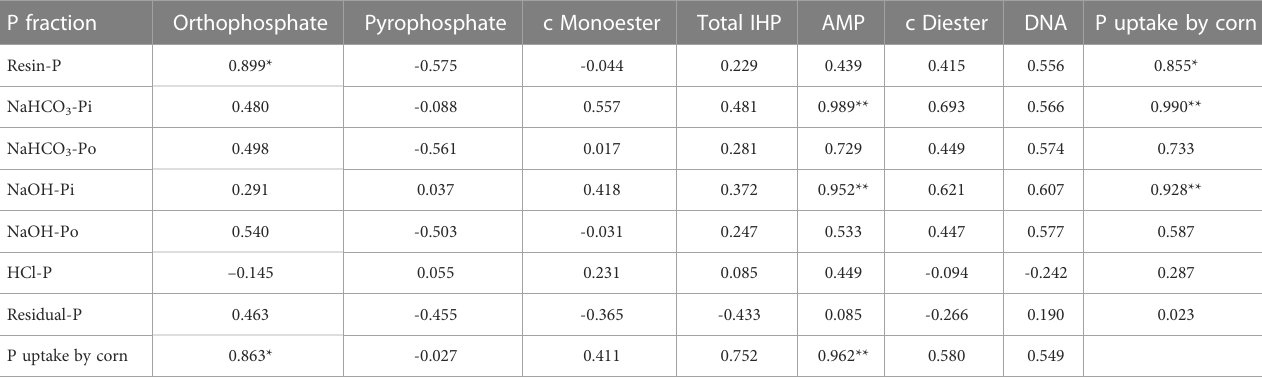
TABLE 1 Correlation coef fi cients among P forms, Hedley-P fractions, and P uptake by corn. P fraction Orthophosphate Pyrophosphate c Monoester Total IHP AMP c Diester DNA P uptake by corn Resin-P